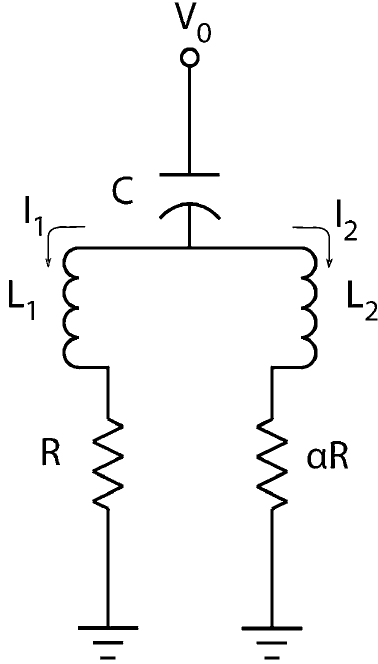
FIG. 9. Schematic of the two switch halves and the circuit model components.